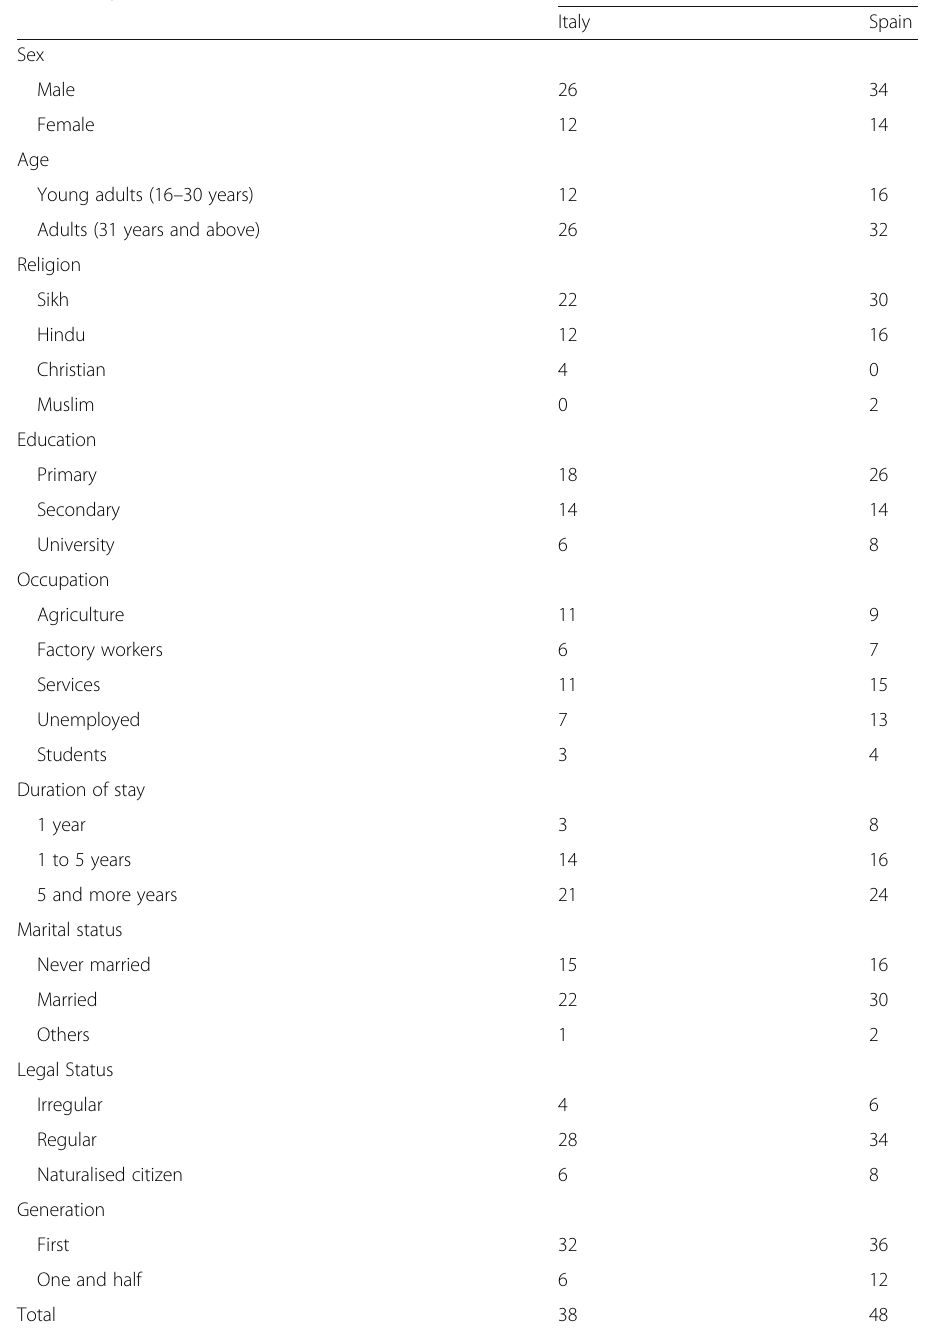
Table 1 Sociodemographic characteristics of the interviewees in Italy and Spain Sociodemographic characteristics